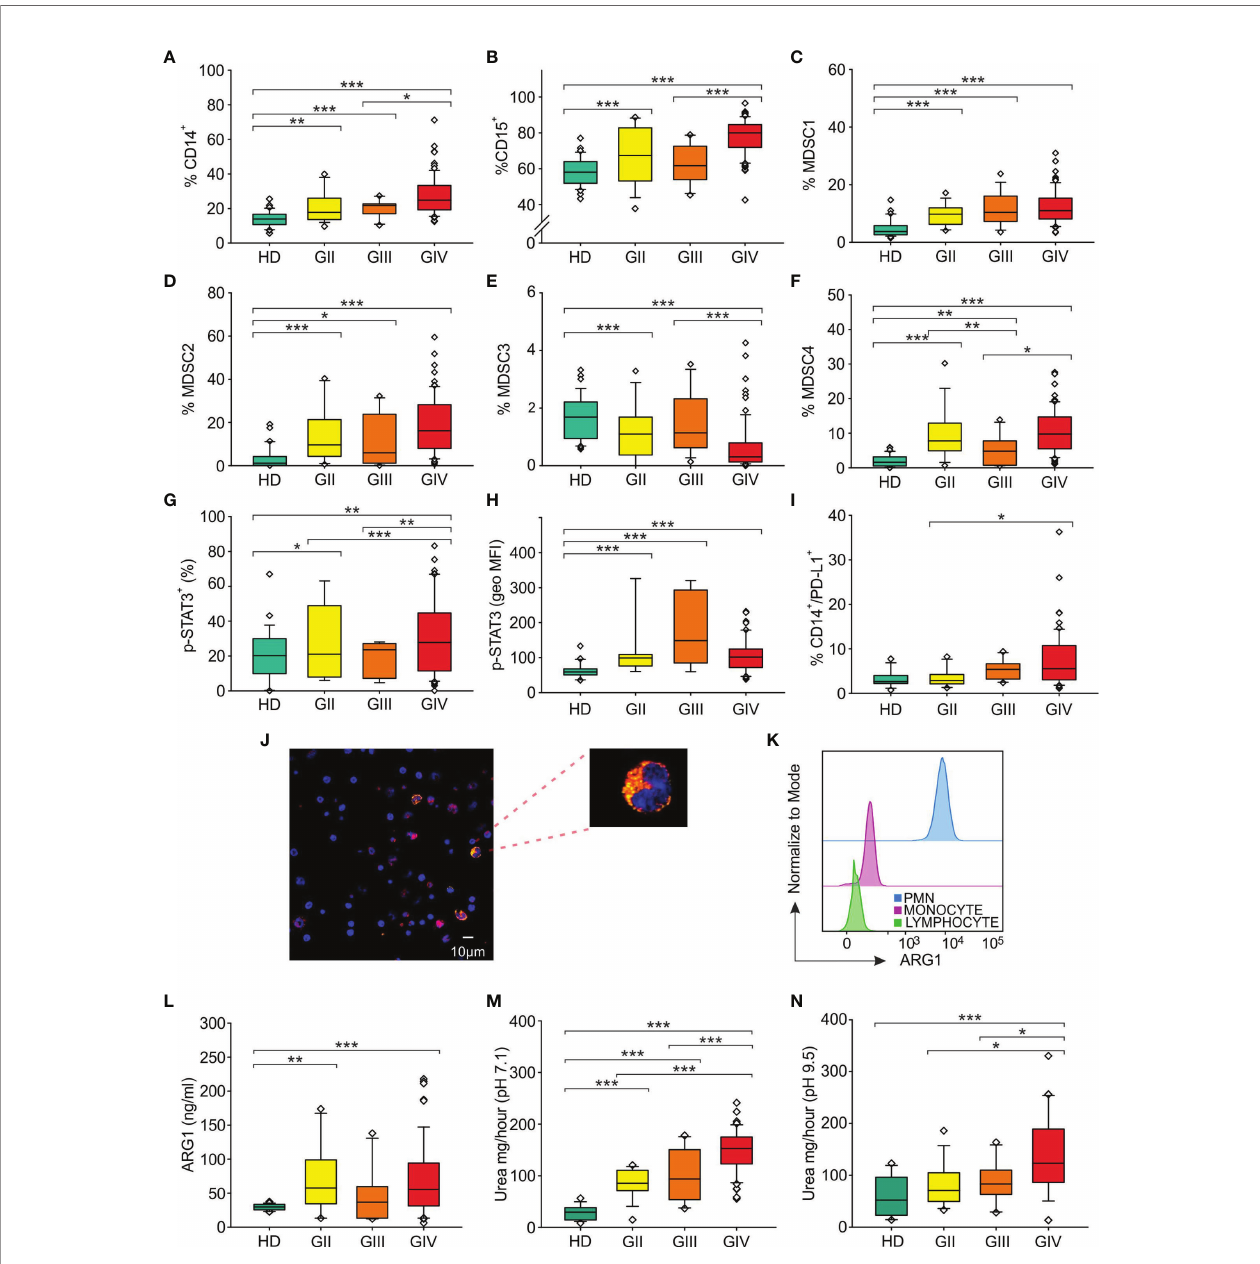
FIGURE 2 | Distribution of circulating myeloid markers in glioma patients. Box plots show the median, 25th, and 75th percentile of the percentage of (A) monocytes (CD14 + cells among PBMCs) [36 HDs, 18 grade II gliomas (GII), 13 grade III gliomas (GIII) and 78 grade IV gliomas (GIV)], (B) granulocytes (CD15 + cells among peripheral blood leukocytes, PBLs) (36 HDs, 18 GII, 13 GIII, and 79 GIV), (C) MDSC1 (CD14 + /IL4R a + cells among PBMCs) (36 HDs, 18 GII, 13 GIII, and 79 GIV), (D) MDSC2 (CD15 + /IL4R a + cells among PMNs) (36 HDs, 17 GII, 12 GIII, and 79 GIV), (E) MDSC3 (Lin − /HLA-DR − /CD11b + /CD33 + cells) in CD15 − cells (36 HDs, 18 GII, 13 GIII, and 79 GIV), (F) MDSC4 (CD14 + /HLA-DR low/ − cells among PBMCs) (36 HDs, 18 GII, 13 GIII, and 76 GIV), (G) p-STAT3 + in CD14 + cells among PBMCs (23 HDs, 8 GII, 6 GIII, and 50 GIV). (H) The geometric mean fl uorescence intensity of p-STAT3 (p-STAT3, geo MFI) expression is shown compared to a negative control by fl ow cytometry in CD14 + cells among PBMCs of 23 HDs and glioma patients (8 GII, 6 GIII, and 50 GIV), following intracellular staining. (I) Surface expression of PD-L1 was evaluated in HDs and glioma patients, by gating CD14 + /PD-L1 + cells among PBMCs (29 HDs, 14 GII, 10 GIII, and 61 GIV). Evaluation of blood ARG1 presence and activity. (J) Representative image of confocal microscopy analysis performed on PBMCs from glioma patients. ARG1 + cells are shown in yellow and CD14 + cells in red. Slides were analyzed at a 63× magni fi cation, and cell size is reported by scale bar (10 µm). Upper right panel shows a 189× magni fi cation of a monocyte positive for both ARG1 and CD14 markers from a GBM patient. (K) Flow cytometry analysis of ARG1 in PMNs (blue), monocytes (pink), and lymphocytes (green). (L) Levels of ARG1 evaluated by ELISA (22 HDs, 15 GII, 10 GIII, and 57 GIV). ARG1 functional activity was tested by urea assay in the plasma of HDs and glioma patients at a 7.1 pH (18 HDs, 15 GII, 10 GIII, and 57 GIV) (M) and at pH 9.5 pH (18 HDs, 15 GII, 10 GIII, and 39 GIV) (N) . Whiskers extend to 1.5 interquartile range, and outliers are shown by dots. Only statistically signi fi cant comparisons are reported in the fi gure: ***<0.001, **<0.01, and